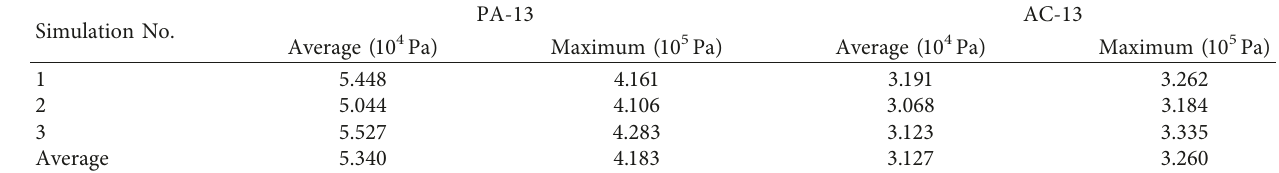
Figure 5: Microscopic contact stresses between aggregates. (a) PA-13. (b) AC-13. Table 6: Simulated microscopic normal contact stresses between aggregates.